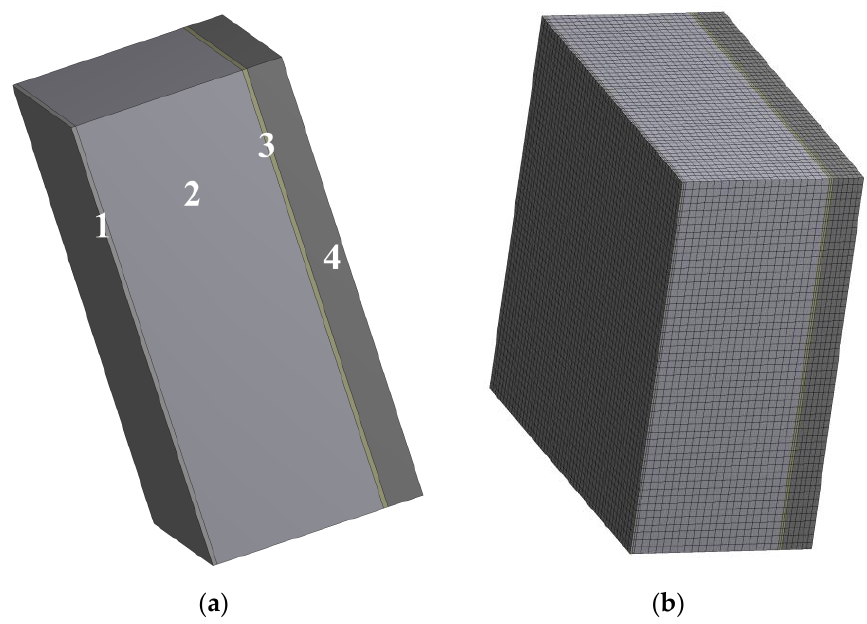
Figure 7. The enclosure section according to Figure 1: ( a ) sketch: 1, 3 — cement-sand plaster; 2 — bearing layer from ceramic brick; 4 — insulant from extruded polystyrene foam; ( b ) finite element model.